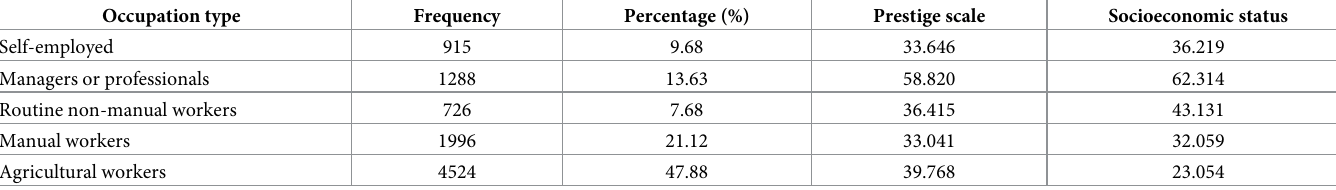
Table 1. Overview of occupation